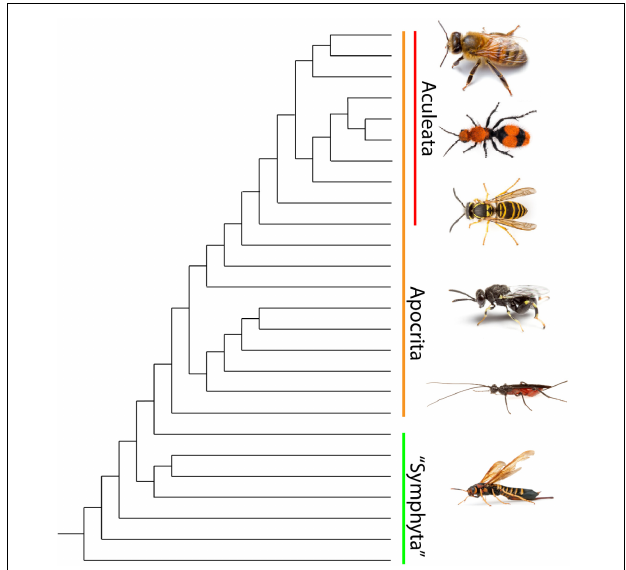
FIGURE 2 | Phylogeny of hymenopteran superfamily relationships after (Branstetter et al., 2017). Symphyta is a paraphyletic grade consisting of the earliest diverging hymenopteran lineages. The monophyletic suborder Apocrita contains all remaining lineages and the bulk of Hymenopteran diversity including the Aculeata. Apidae and Chalcididae images are ©Matt Bertone, used with permission. All other images are ©Alex Wild, used with